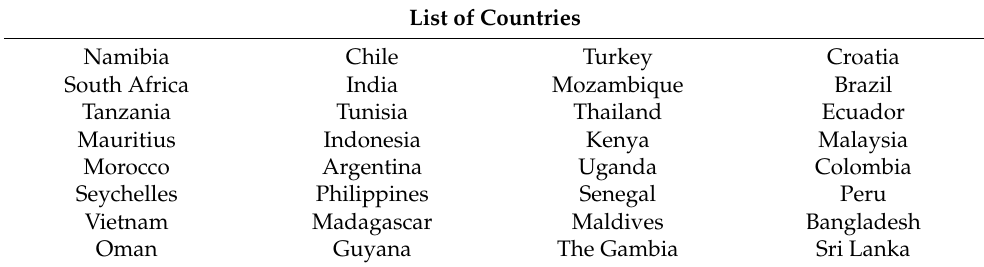
Table A1. List of countries in the estimations.